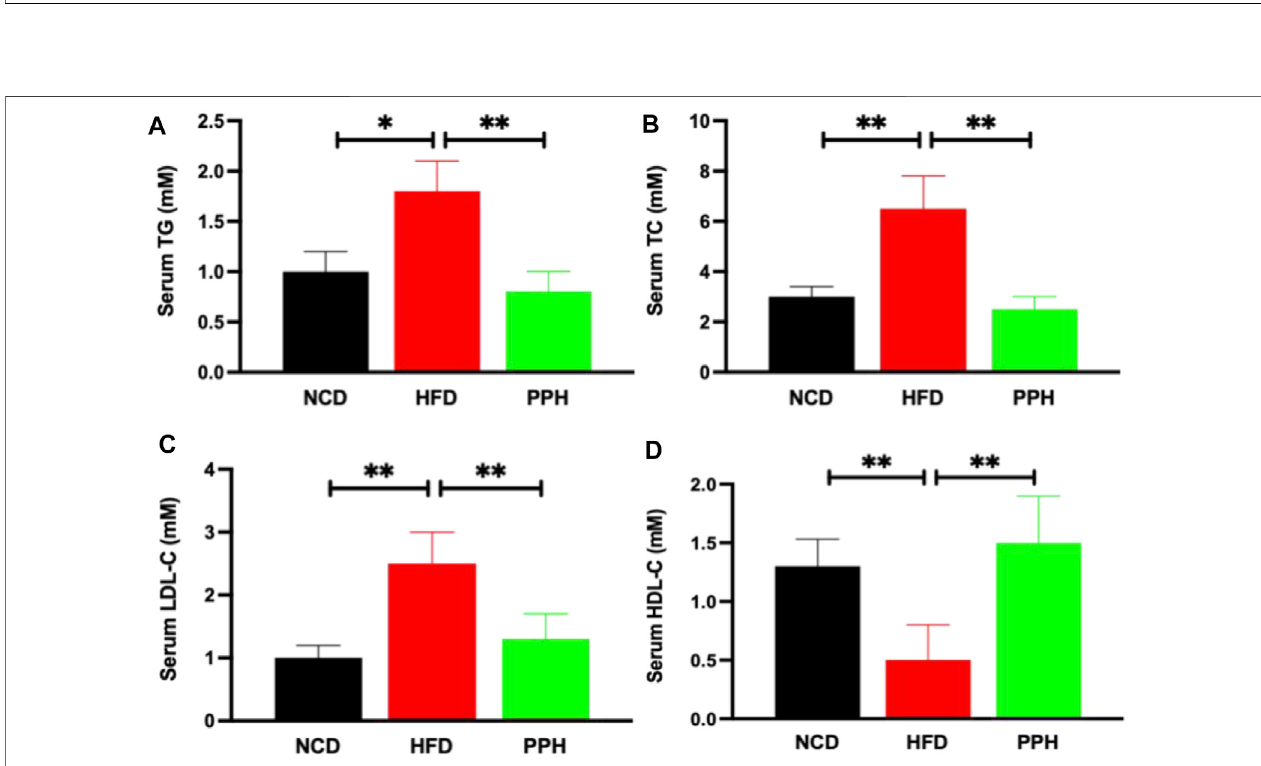
FIGURE7| EffectsofPPHonserumlipidsinobesemice.Serumtriglyceride(TG) (A) ,totalcholesterol(TC) (B) ,low-densitylipoproteincholesterol(LDL-C) (C) ,and high-density lipoprotein cholesterol (HDL-C) (D) levels. * p < 0.05, ** p < 0.01.